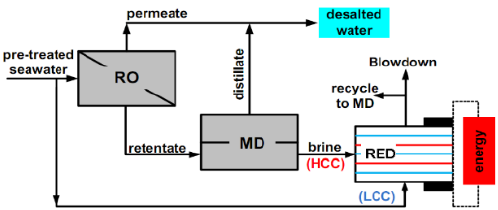
Figure 4. Integrated application of MD with RO and RED (reverse electrodialysis) for water and energy production [26]. HCC and LCC represent High Concentration Compartment and Low Concentration Compartment of the RED cell, respectively.